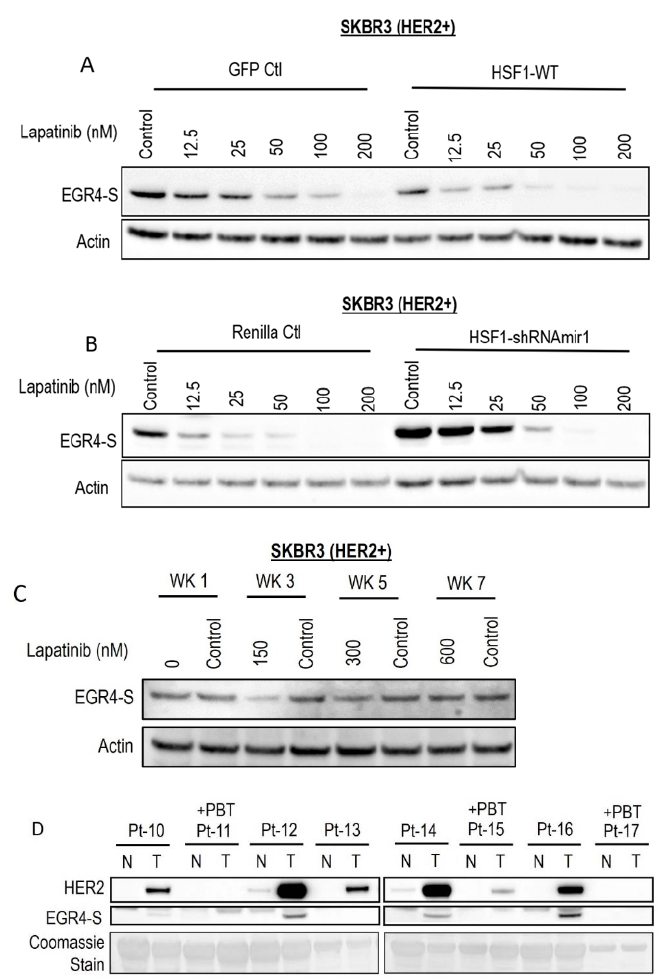
Figure 6. EGR4-S expression is responsive to HER-targeted treatment and sensitive to altered HSF1 activity. ( A ) Lapatinib treatment of HER2+ cells, with/without elevated HSF1 and ( B ) with/without HSF1 shRNA knockdown. ( C ) EGR4-S expression in cells grown in increasing concentrations of lapatinib over the course of 7 weeks exhibits some reduction visible at 3 weeks. ( D ) Comparison of HER2 and EGR4-S protein expression in tumour (T) tissue and adjacent normal (N) tissue from eight different breast cancer patients (Pt 1–8) diagnosed with HER2+ tumours. Pt 11, 15, and 17 received pre-biopsy treatment (+PBT) to suppress the HER2